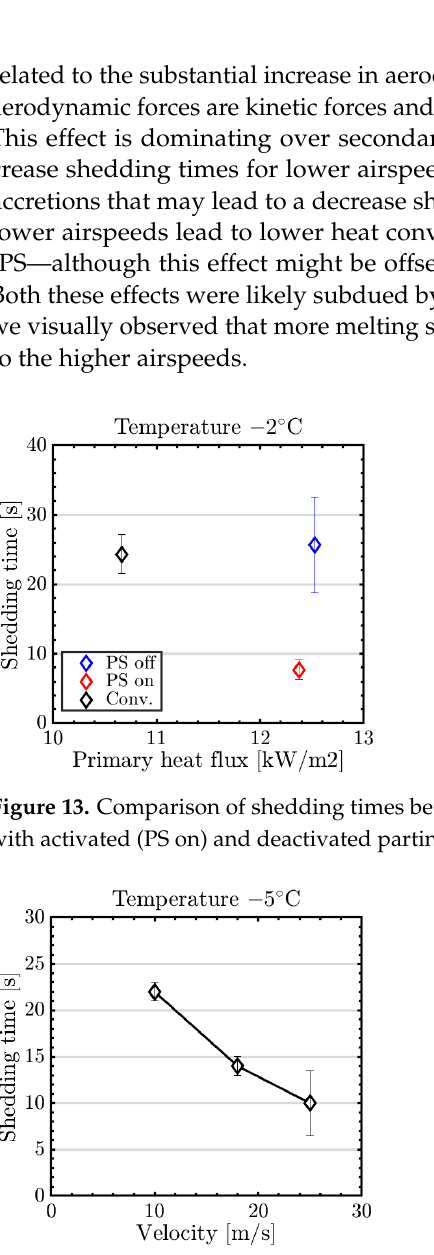
Figure 14. Comparison of shedding times of the parting strip IPS at different velocities.